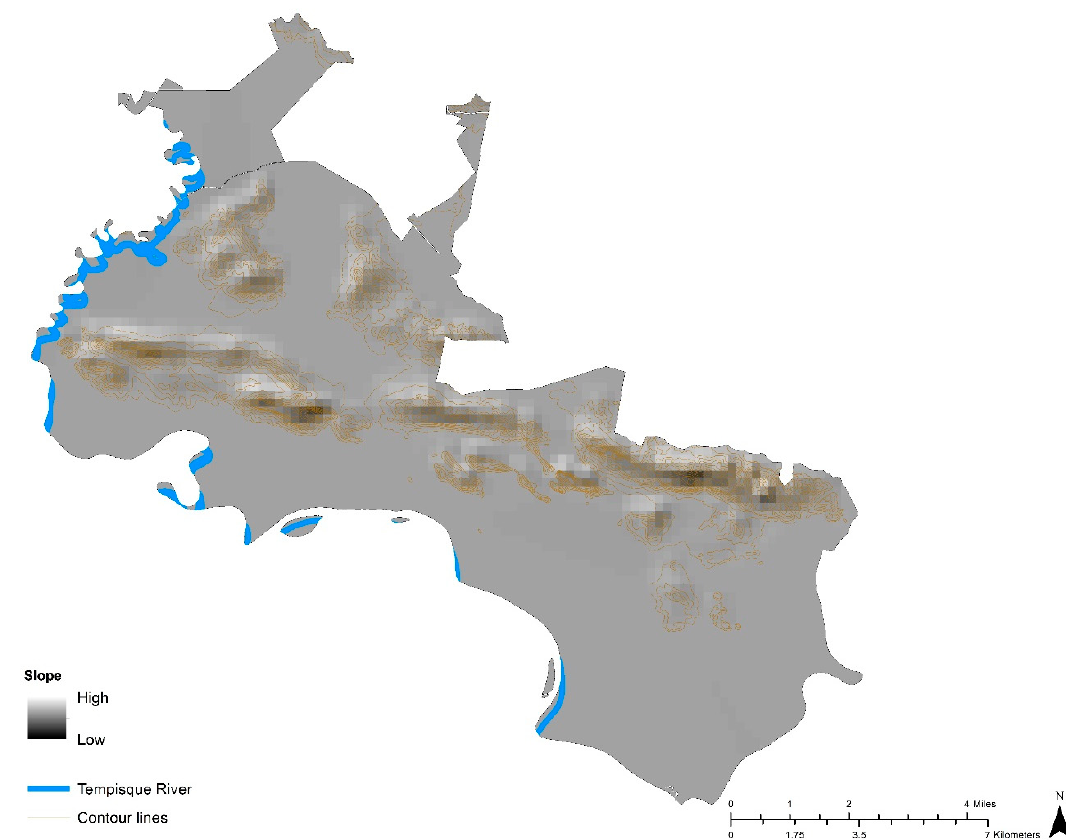
Figure 3. Elevation map of Palo Verde National Park in Guanacaste showing the relief of the area.